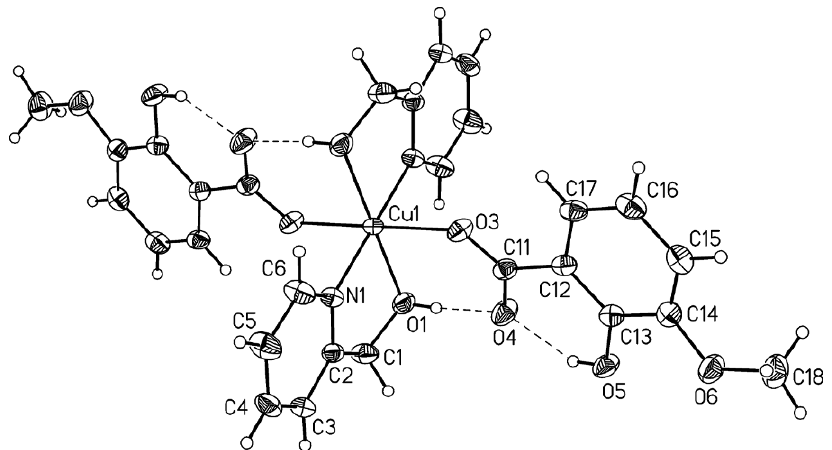
Figure 2. Perspective view of [Cu(3-MeOsal) at 30% probability level.